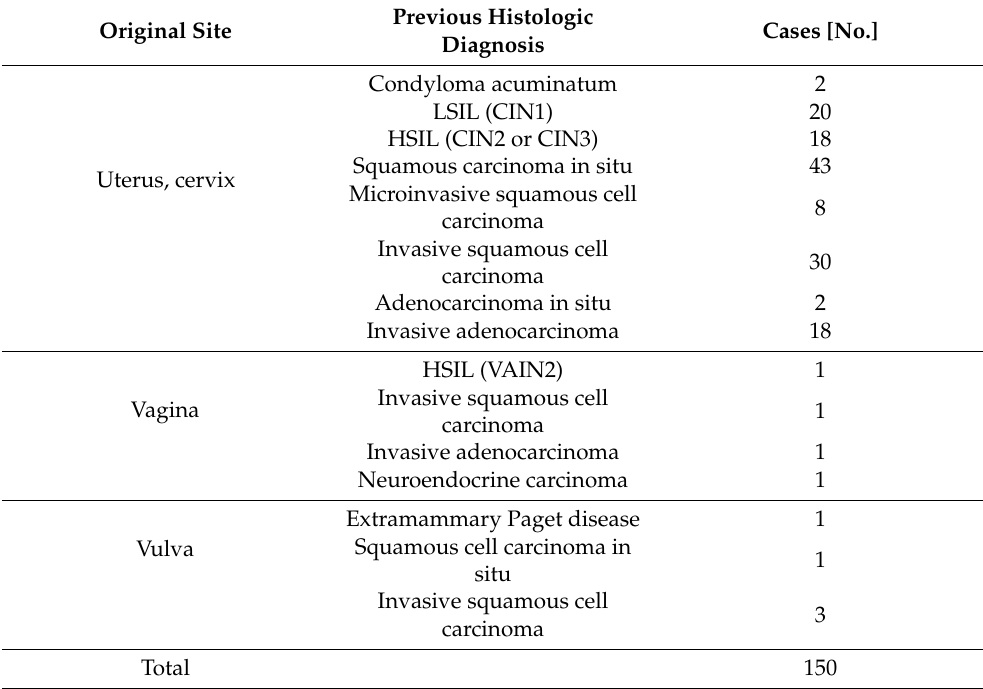
Table 1. Previous HPV-related lesions of the cases with low (1+) VL of HPV. Previous Histologic Original Site